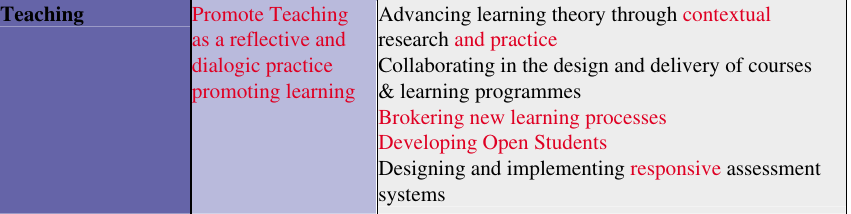
Figure 4. Teaching ‘type’ of Boyer’s Model of Scholarship